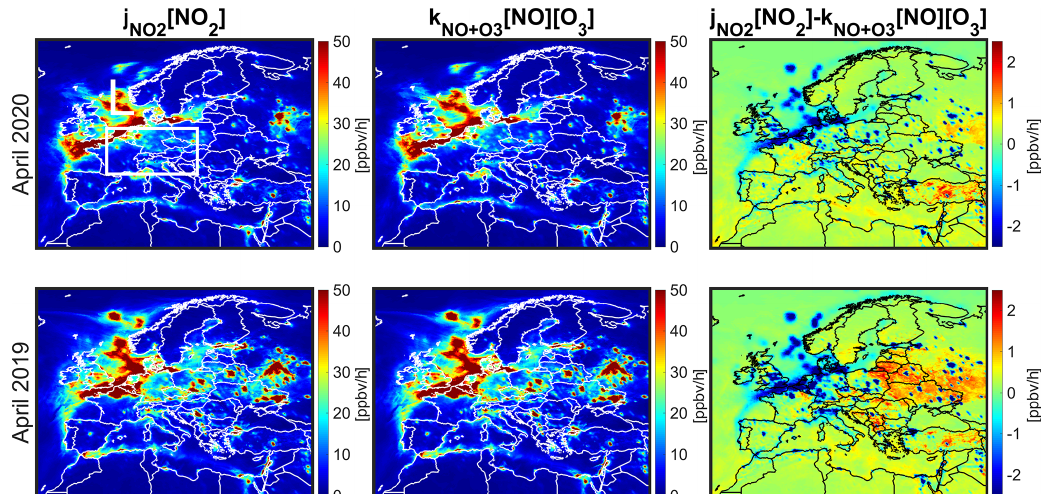
Figure 12. Surface chemical processes involved in Eq. (6) (ppbvh − 1 ) pertaining to the O 3 –NO–NO 2 partitioning in April 2020 and 2019 during MDA8 hours. The constrained model by the satellite observations is used to derive these